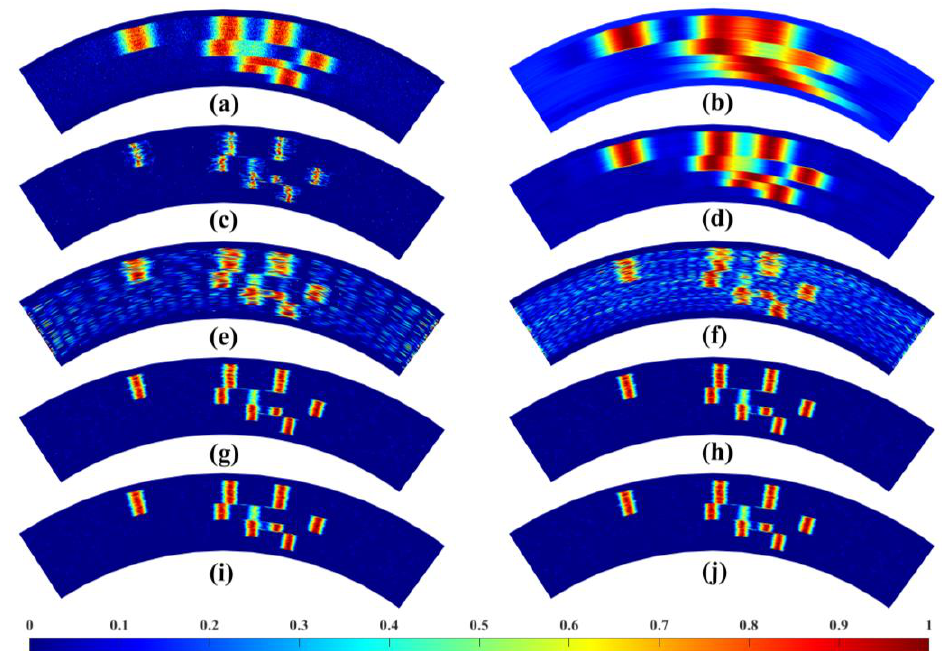
Figure 12. Restored results of simulated surface targets with convolution and noise degradation when SNR of noise is 15 dB. ( a ) Blind deconvolution. ( b ) Regularized Filtering. ( c ) Richardson – Lucy. ( d ) Wiener Filtering. ( e ) TSVD. ( f ) SDBSM. ( g ) TV. ( h ) TV BC. ( i ) TVS. ( j ) TVSBC.